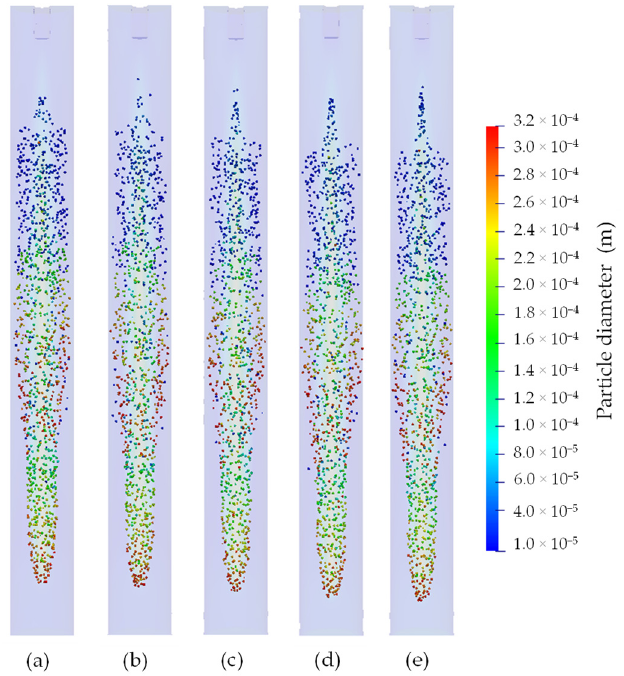
Figure 8. Numerical particle diameter distributions along the downer reactor under different operating conditions: ( a ) U G = 0.11 m/s; ( b ) U G = 0.15 m/s; ( c ) U G = 0.18 m/s; ( d ) U G = 0.23 m/s; ( e ) U G = 0.27 m/s.